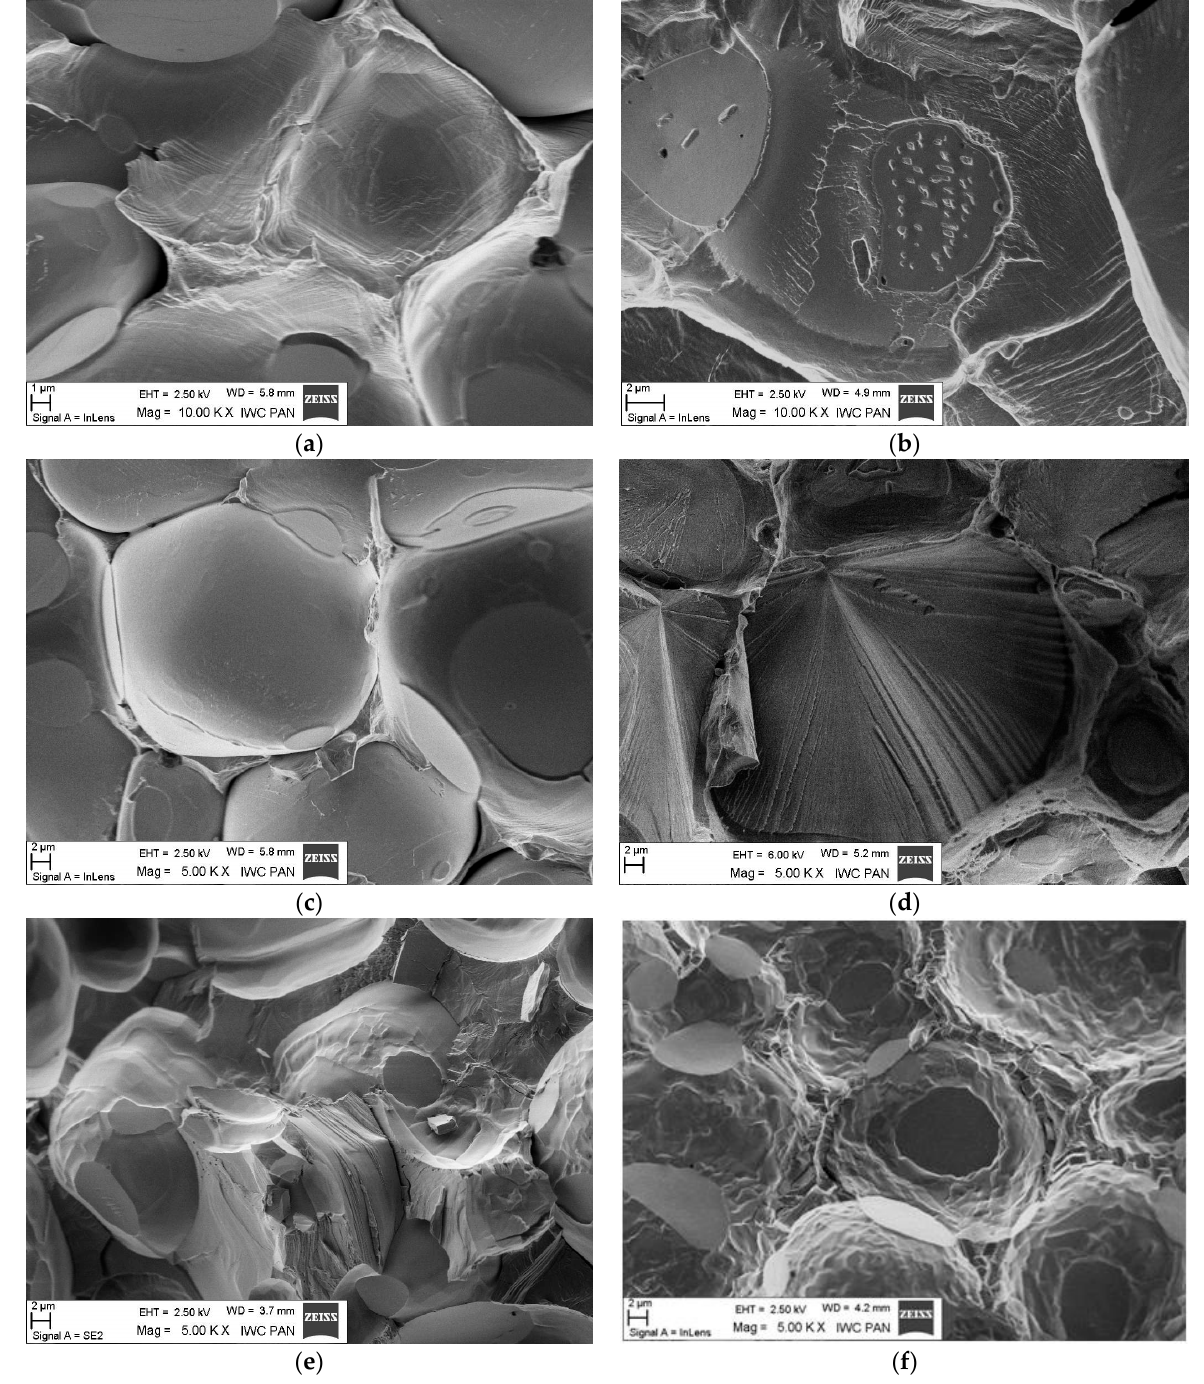
Figure 4. SEM images of the fracture surface of the alloys: WNi9Co1, WNi7Co3, and WNi5Co5 directly after sintering ( a , c , e ) and after heat treatment ( b , d , f ). Magnification: ( a , b ) 10,000 × , and ( c – f ) 5000 ×